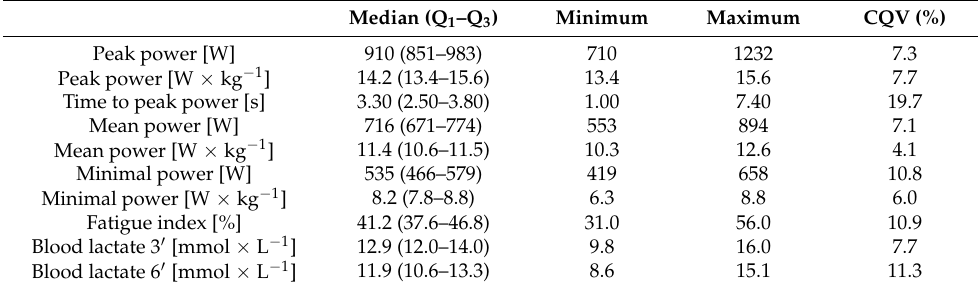
Table 2. Kinetic data collected during the effort and BL concentration after its completion.